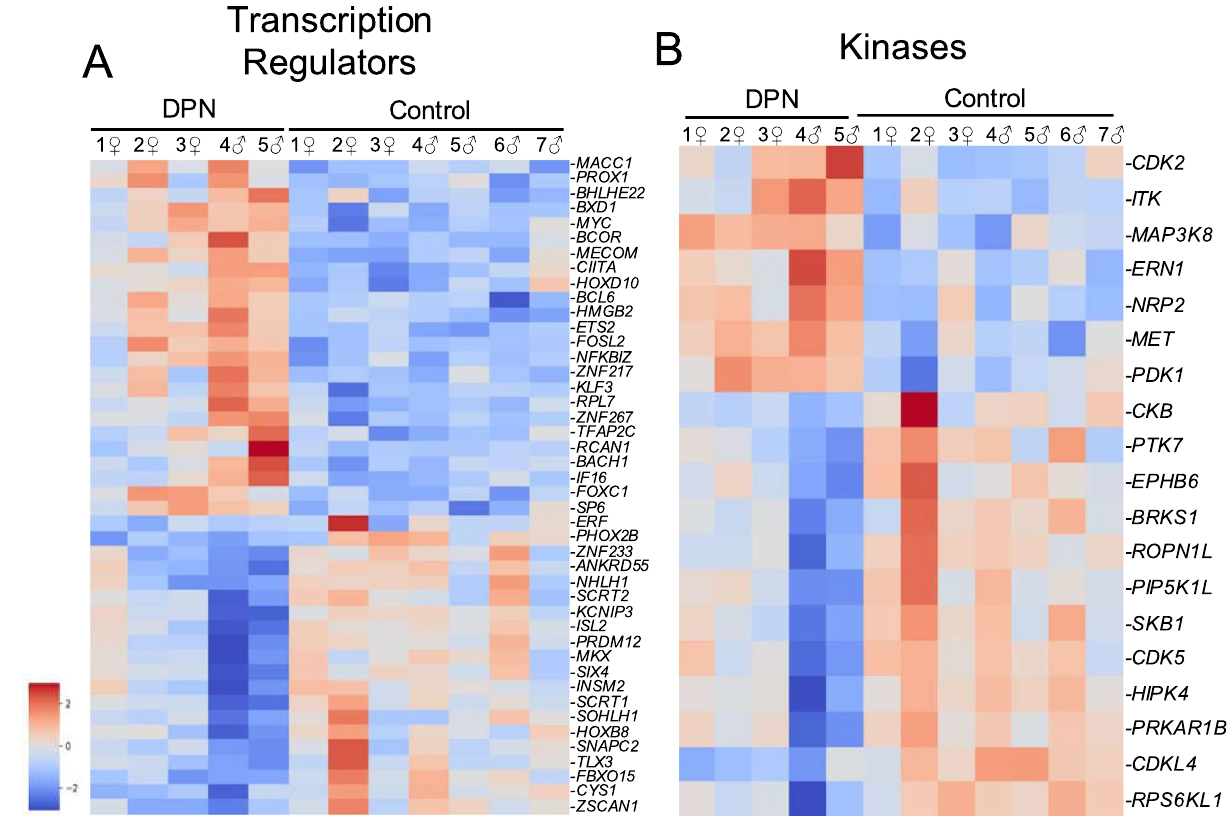
Figure 2. Heatmaps of dysregulated genes belonging to functional protein classes associated with pain signaling. Pictured are heatmaps of ( A ) transcriptional regulators and ( B ) kinases. Inflammation can cause gene expression changes in nociceptors through downstream intracellular signaling cascades that ultimately activate various transcription factors. Inflammatory signaling can additionally stimulate protein kinases that can then modulate pain transducing ion channels to induce peripheral